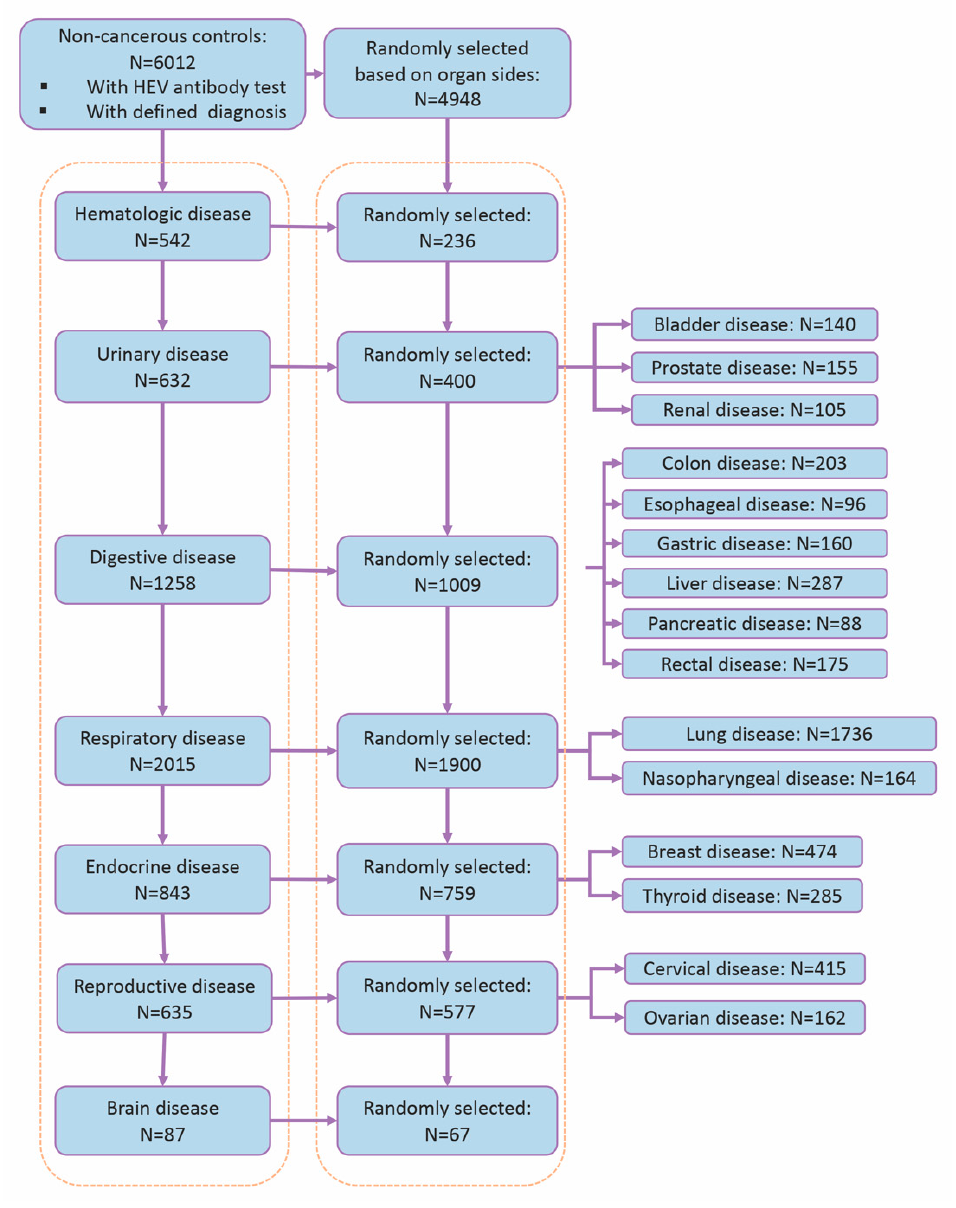
Figure 1. Flowchart of selection of controls in the study.